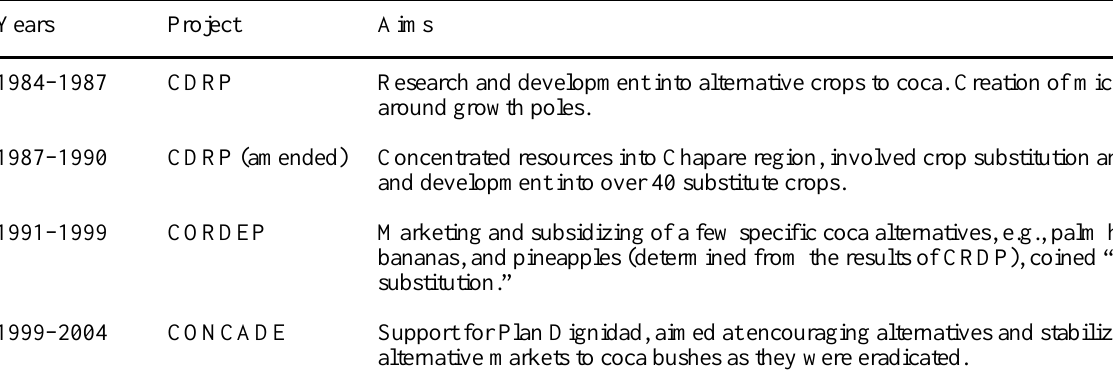
Table 2. Duration and aims of alternative development programs used as part of anti-coca policies (sources: Bostwick et al. 1990, Ortuño 2002, Jackson et al. 2003). CDRP = Cochabamaba Regional Development Program; CORDEP = Chapare Regional Development Project; CONCADE = Counter-Narcotics Consolidation of Alternative Development